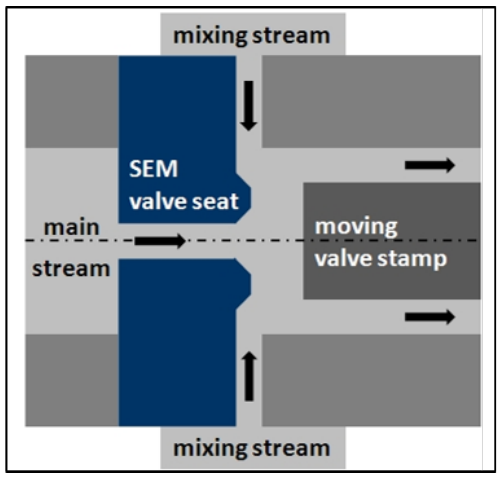
Figure 7. Principle of SEM flat valve for dairy homogenization.